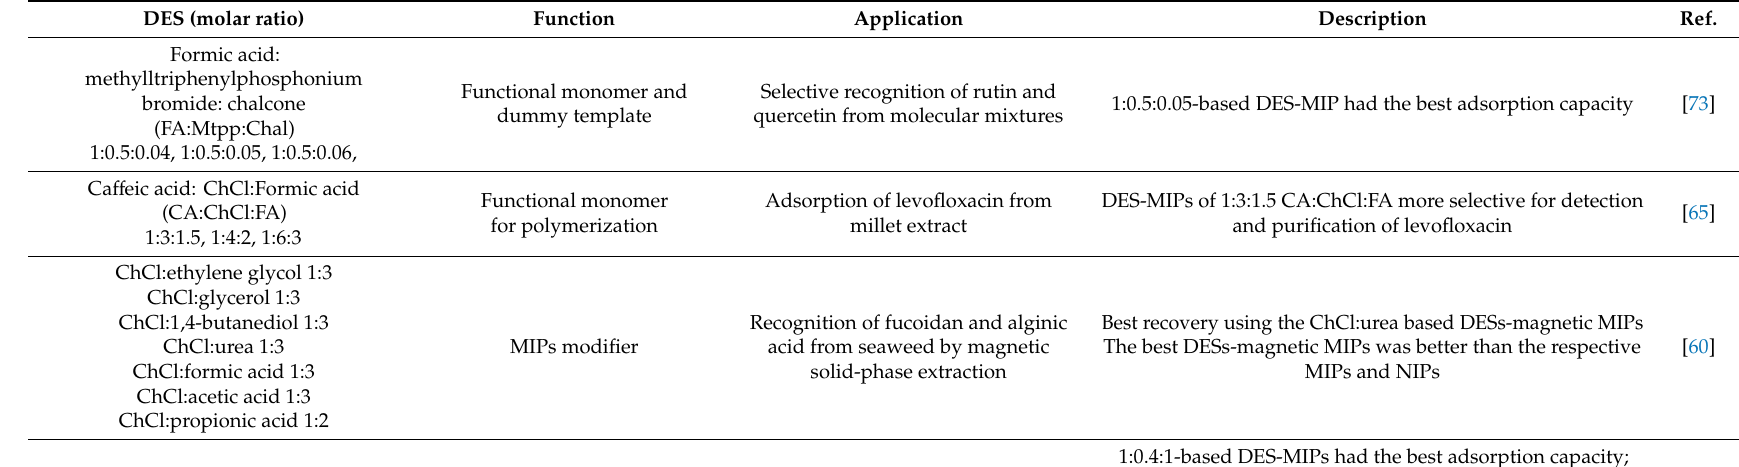
Table 2. Cont. Selective recognition of rutin and quercetin from molecular